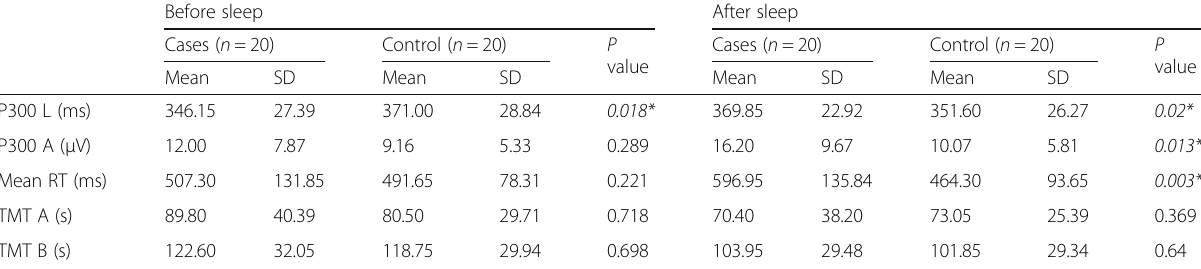
Table 1 Comparison between P300 and TMT in cases and controls Before sleep After